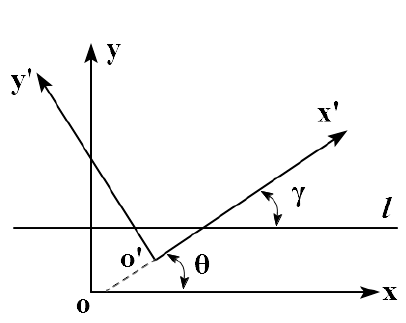
Figure 11. Simplified coordinate model.